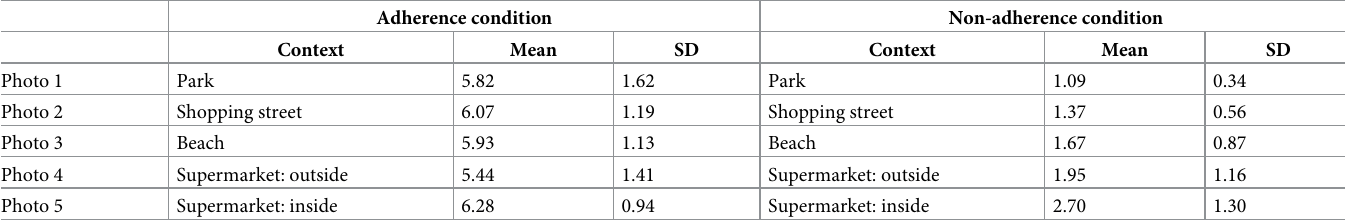
Table 1. Selected images with mean and standard deviation for the adherence score as asked in the image pilot